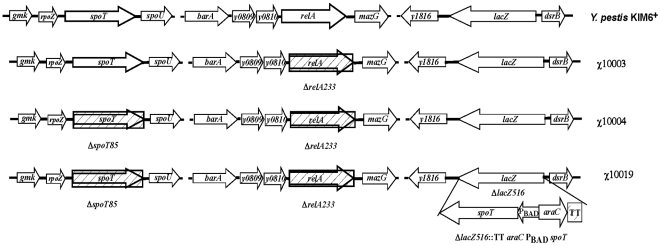
Schematic chromosome structure of Y. pestis KIM6+, χ10003 (ΔrelA233), χ10004 (ΔrelA233ΔspoT85) and χ10019 (ΔrelA233 ΔspoT85 ΔlacZ::TT araC PBAD
spoT).